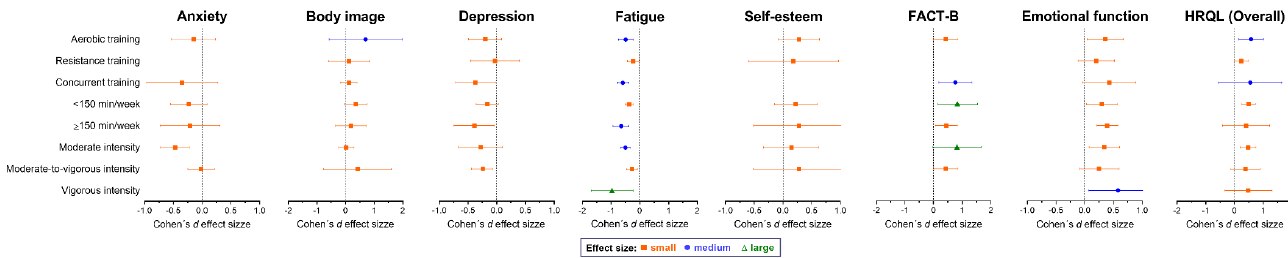
Figure 3. Exercise effects on mental health parameters.